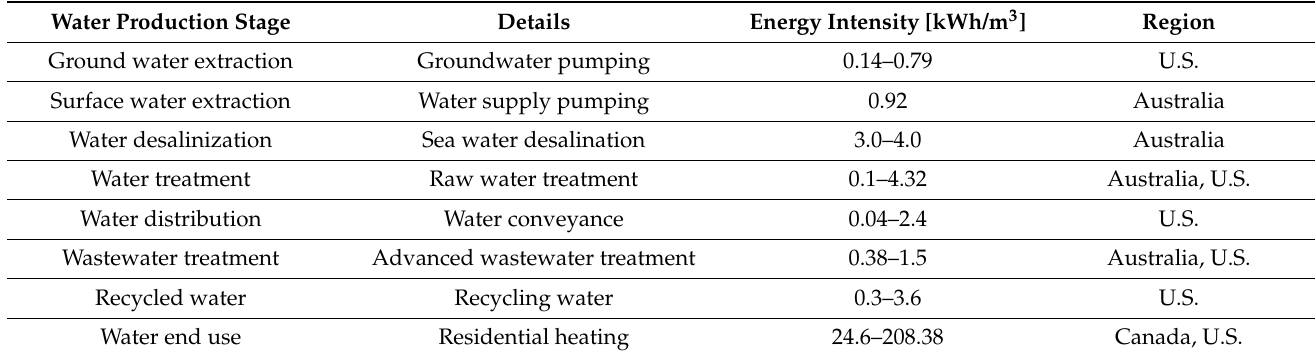
Table 10. Maximum and minimum values of the energy intensities corresponding to the different stages of water supply, in different regions of the world; review adapted after